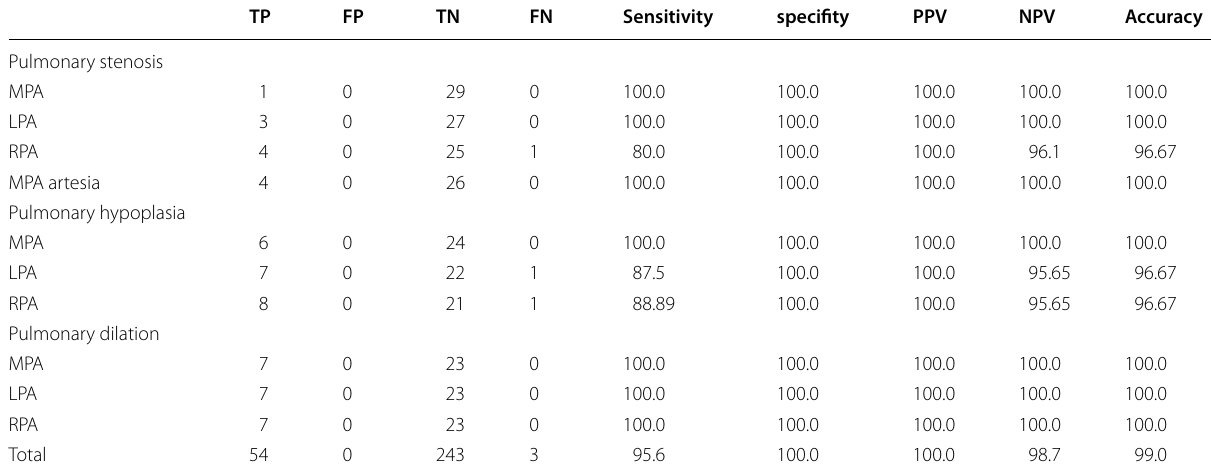
* significant p value (< 0.05)